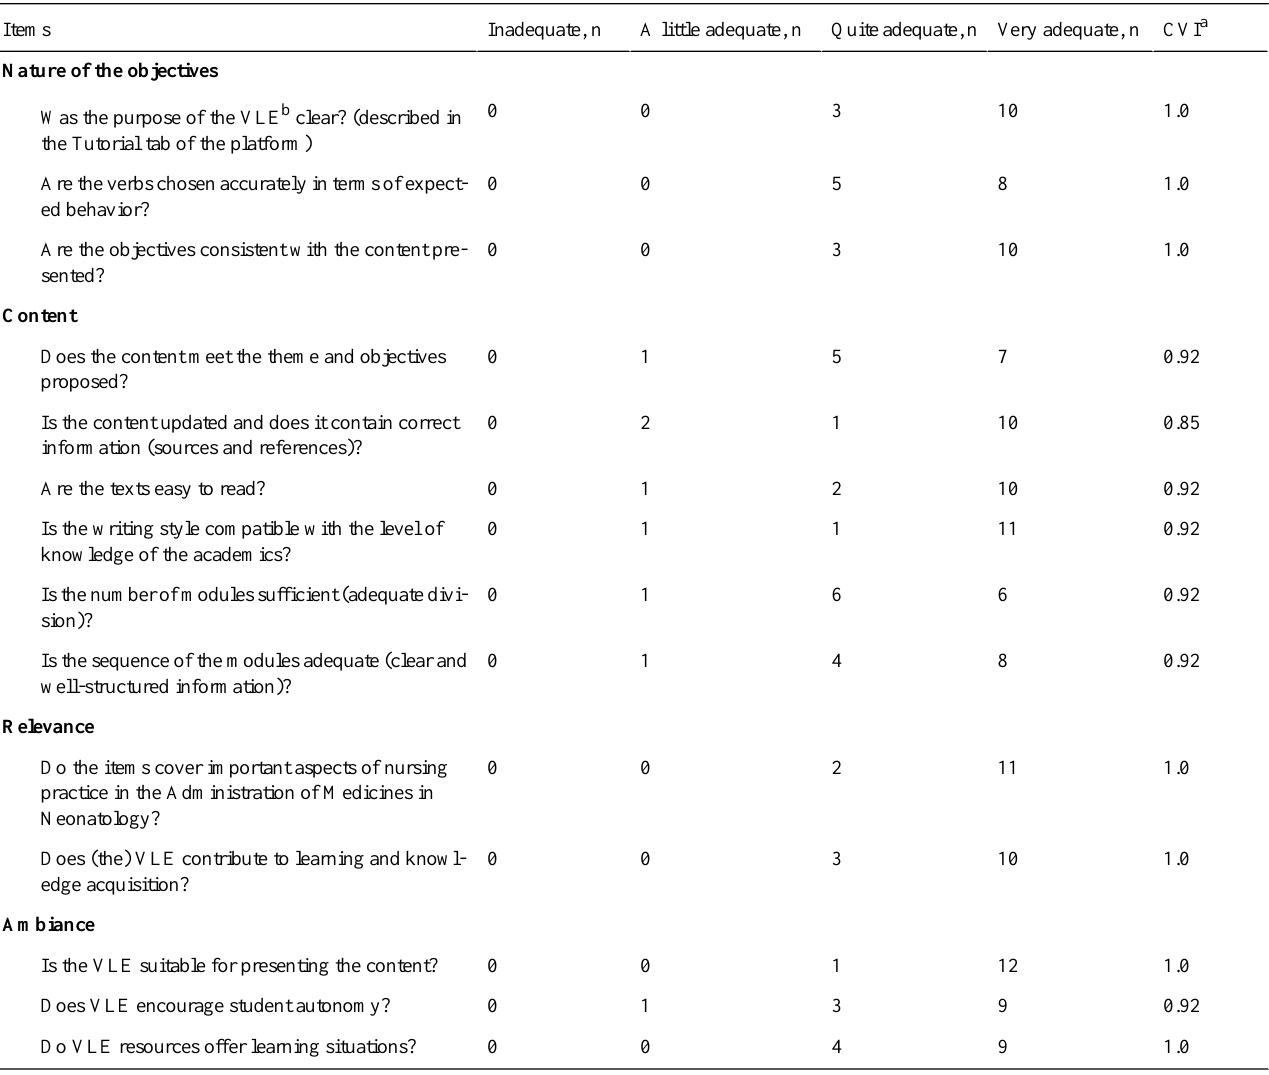
Table 2. Responses from experts and content validity index